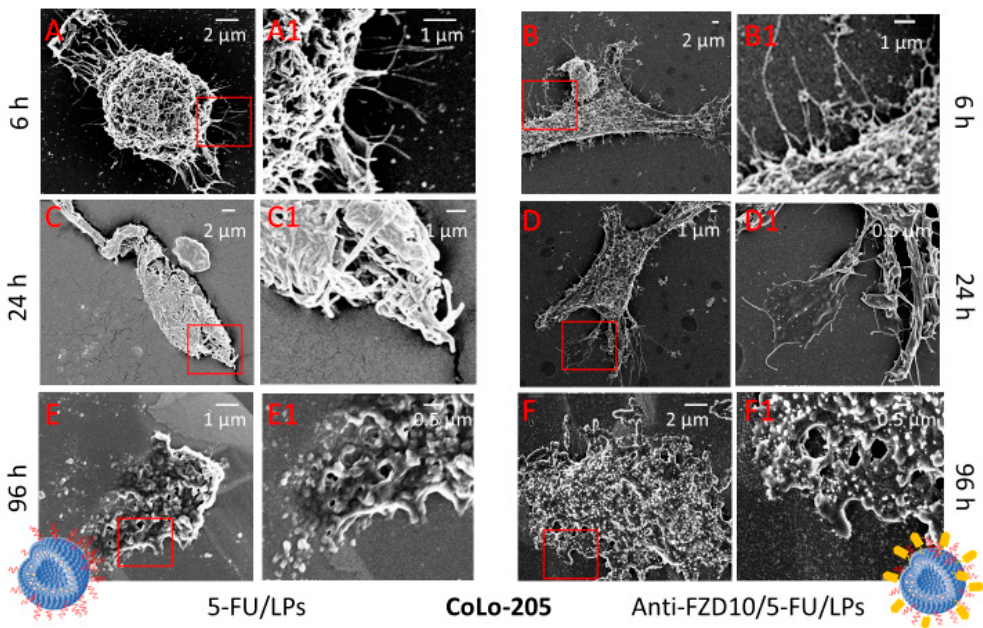
Figure 4. (FE-SEM) Representative field emission scanning electron microscopy micrographs(EHT) extra-high tension (EHT = 3.00 kV) and their corresponding close-up details at higher magnification of CoLo-205 cells after treatment with 5-FU/LPs ( A , A1 , C , C1 , E , E1 ) and anti-FZD10/5-FU/LPs ( B , B1 , D , D1 , F , F1 ) for 6, 24 and 96 h. 5-FU concentration: 2 µM. Pharmaceutics 2020 , 12 , x